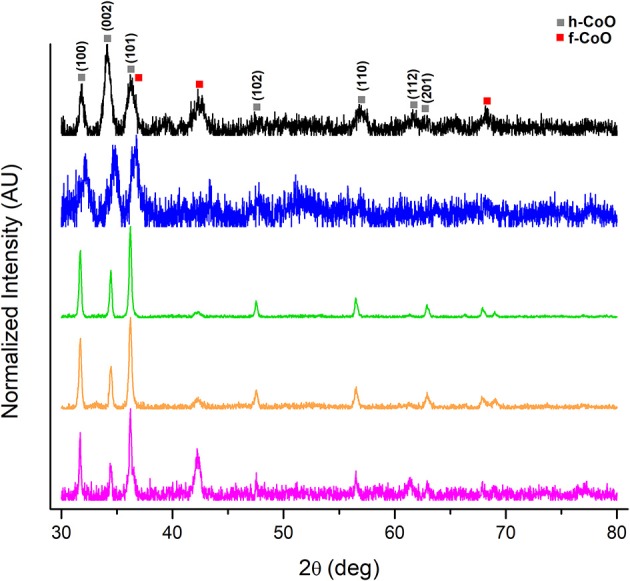
XRD patterns of h-CoO nanoparticles prepared at varied synthesis conditions showing preferential growth along the c-axis (black: 200°C, 5.5°C/min, 0.1M CoAc, blue: 270°C, 1°C/min, 0.15M CoAc, green: 270°C, 10°C/min, 0.05M CoAc, orange: 270°C, 10°C/min, 0.15M CoAc, pink: 270°C, 1°C/min, 0.05M CoAc).